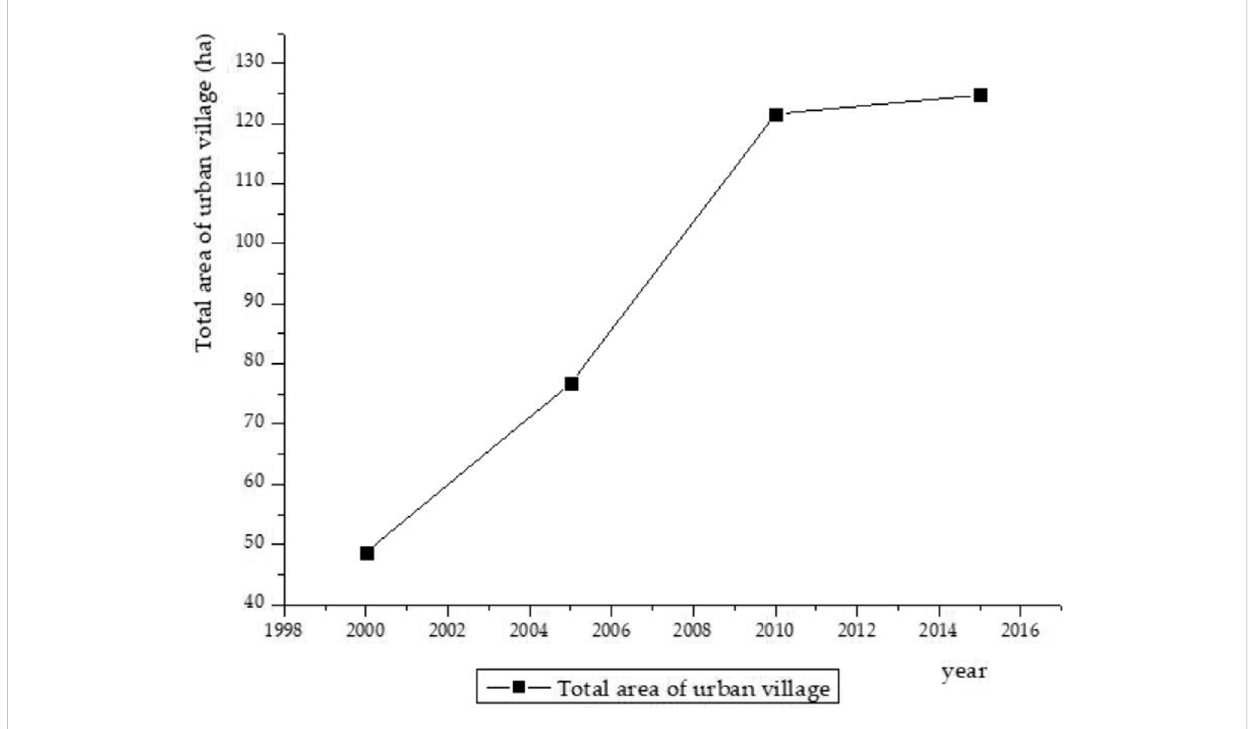
FIGURE 6 Growth of urban village area from 2000 to 2015 in Guangzhou (Source: Drawn by the authors).